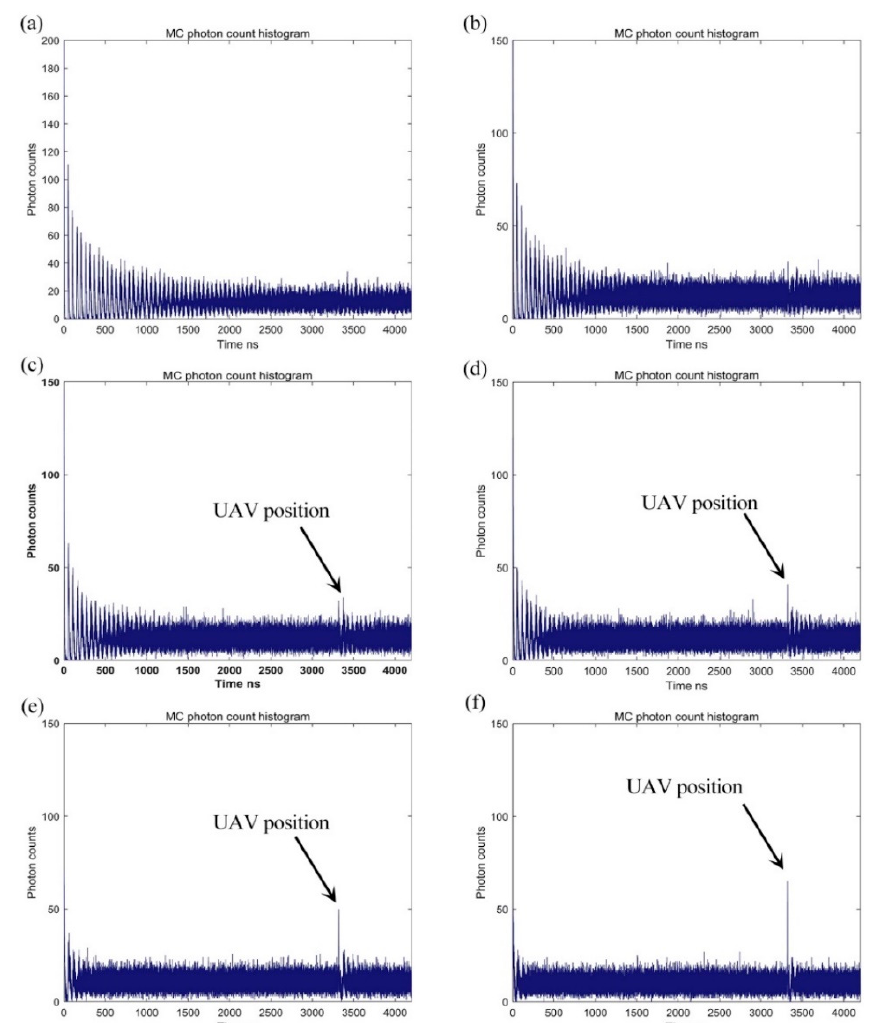
Figure 4. Photon echoes in different fields of view under daylight conditions. The field of view Angle in the simulation is ( a )1.2mrad, ( b ) 1.0mrad, ( c ) 0.9 mrad, ( d ) 0.8 mrad, ( e ) 0.6 mrad, and ( f ) 0.5